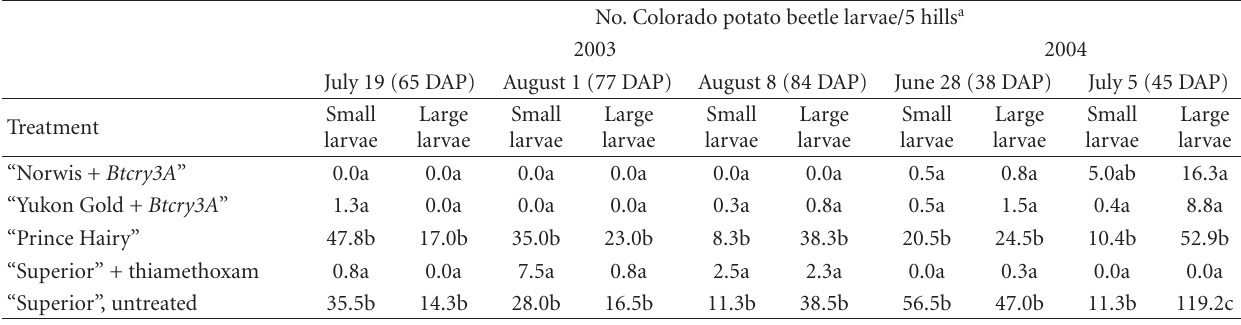
Table 1: Densities of small (1st and 2nd instar) and large (3rd and 4th instar) Colorado potato beetle larvae on potato lines in two years (2003 and 2004) of field trials in Bridgeton,